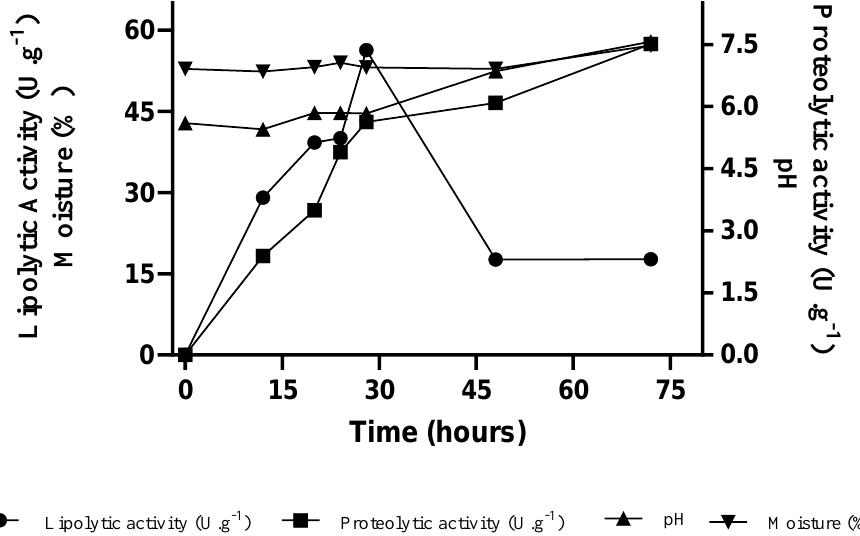
Figure 3. Enzyme activity and cultivation conditions of the matrix andiroba oil cake and soybean meal (50:50) supplemented with 1.5 (% w / v ) soybean oil.